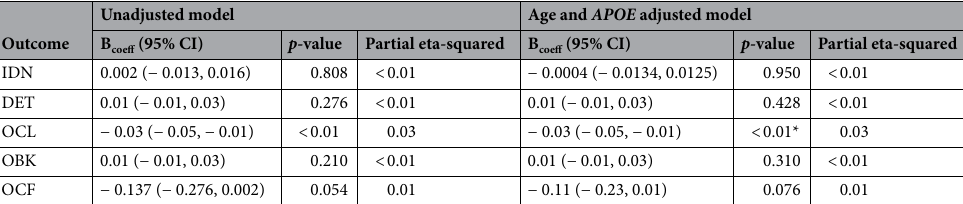
Table 2. Linear regression analyses for predicting cognitive function using BIN1 carrier status. IDN (identification) task measures visual identification/attention, DET (detection) task measures psychomotor function, OCL (one-card learning) task measures recognition memory/learning, OBK (one-back) task measures working memory and OCF refers to the overall cognitive function. *Significant after false discovery rate (Benjamini–Hochberg)